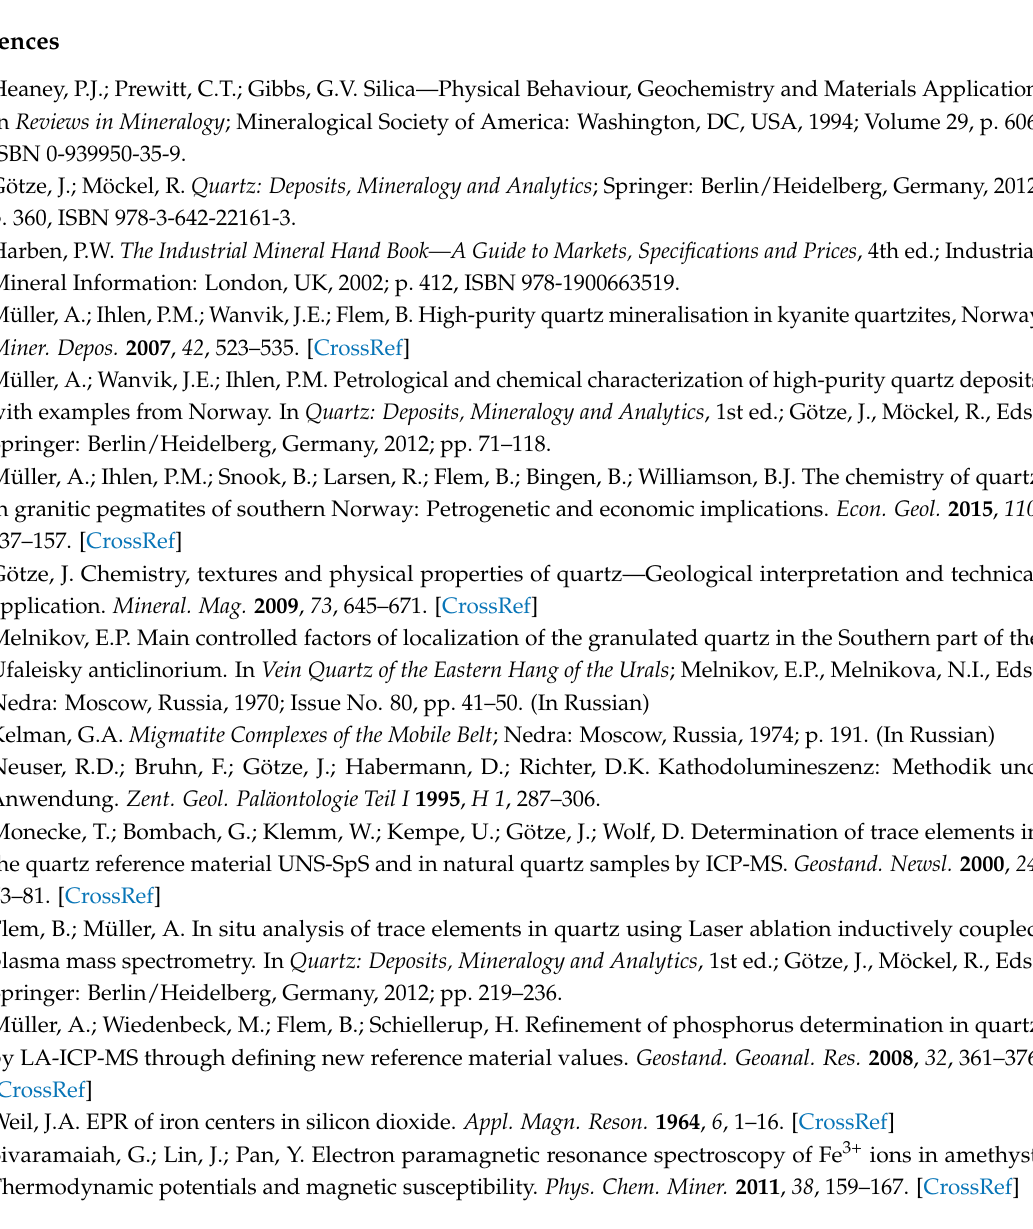
Table S1: Trace-element concentrations of investigated quartz samples analysed by solution ICP-MS (results in ppm), Table S2: REE concentrations (results in ppm) and chondrite-normalized interelemental ratios of investigated quartz samples analysed by solution ICP-MS, Table S3: Results of spatially resolved trace-element analyses by LA-ICP-MS (in